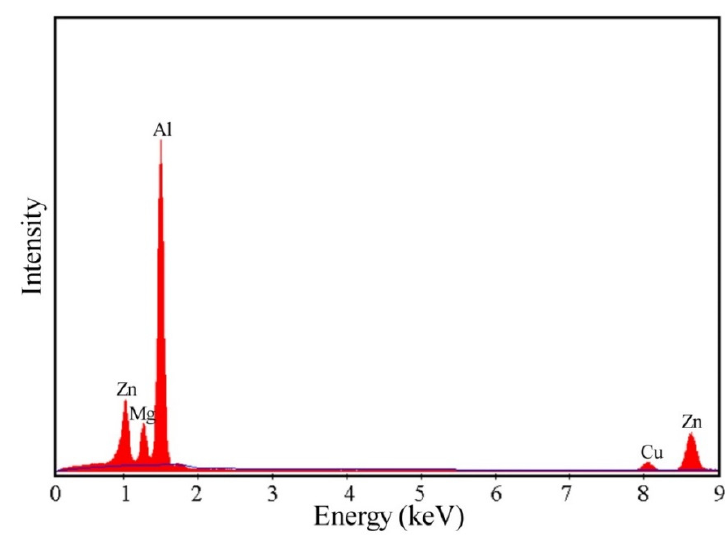
Figure 10. EDS analysis result of the particle marked with circle in Figure 9.